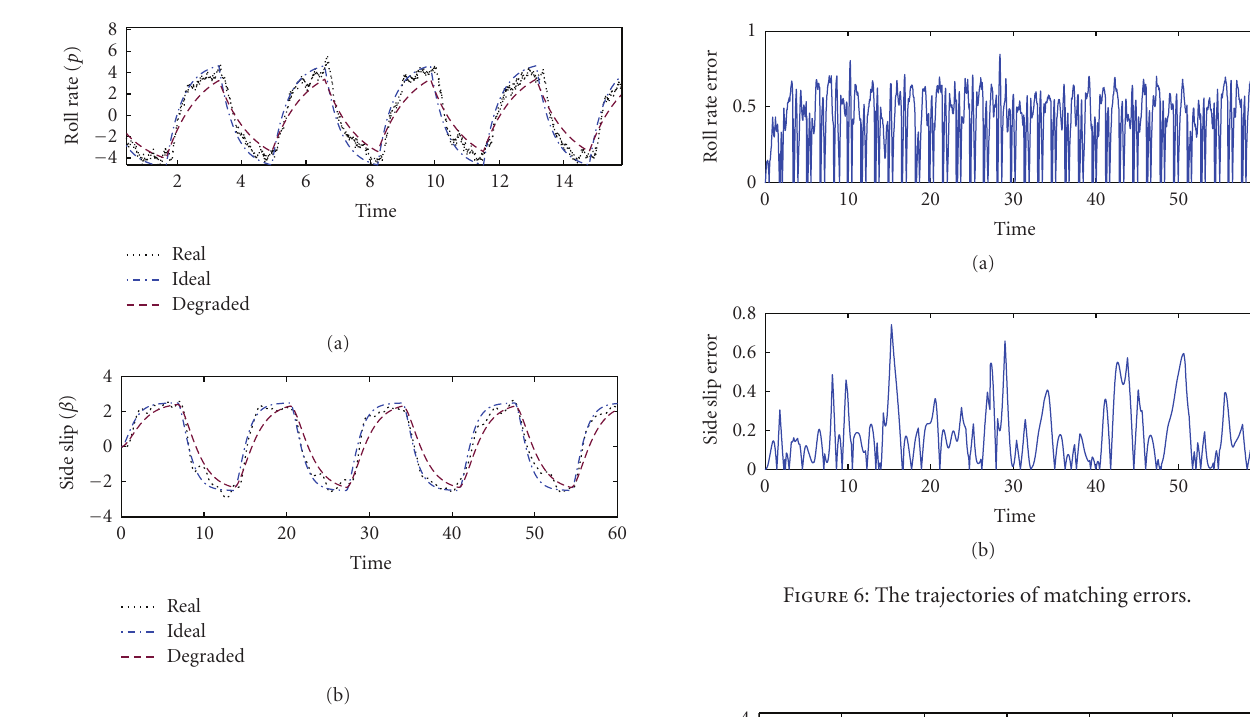
Figure 5: Output trajectories.